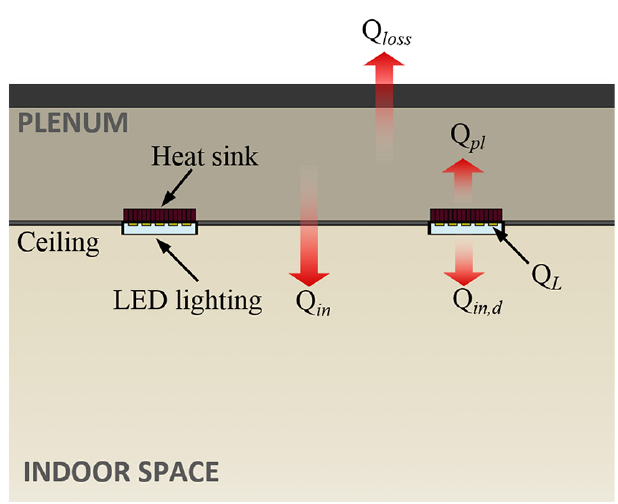
Figure 1. Schematic view of the indoor heat gain from LED